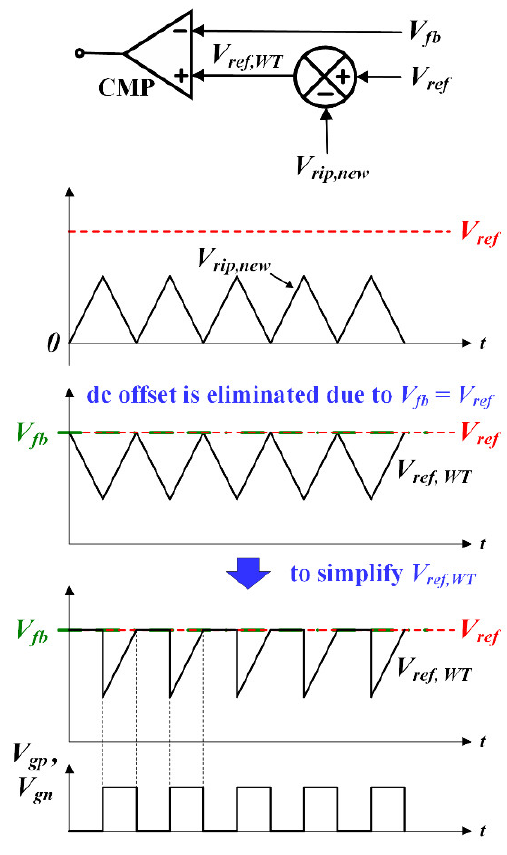
Figure 6. Concept of WTR control.